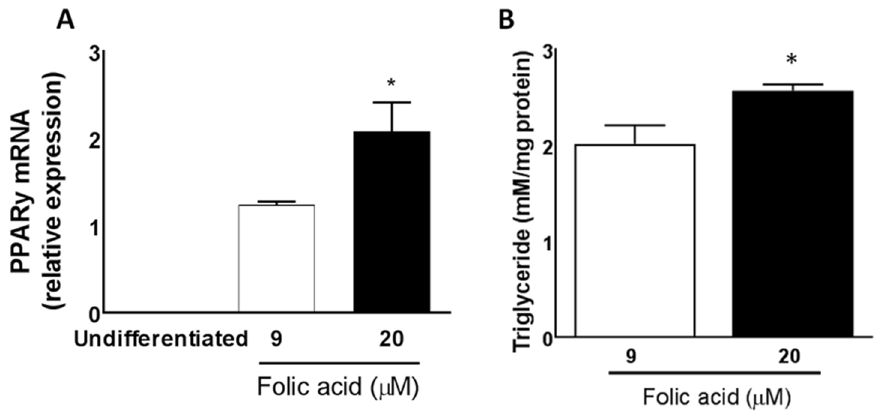
Figure 7. Folic acid increases PPAR γ and triglyceride levels in a dose ‐ dependent manner in cultured 3T3 ‐ L1 cells. ( A ) Relative PPAR γ mRNA levels in cells cultured with 9 μ M or 20 μ M folic acid and ( B ) Triglyceride levels in cells after treatment with 9 μ M compared to 20 μ M folic acid. Values are means ± SEM, * p <